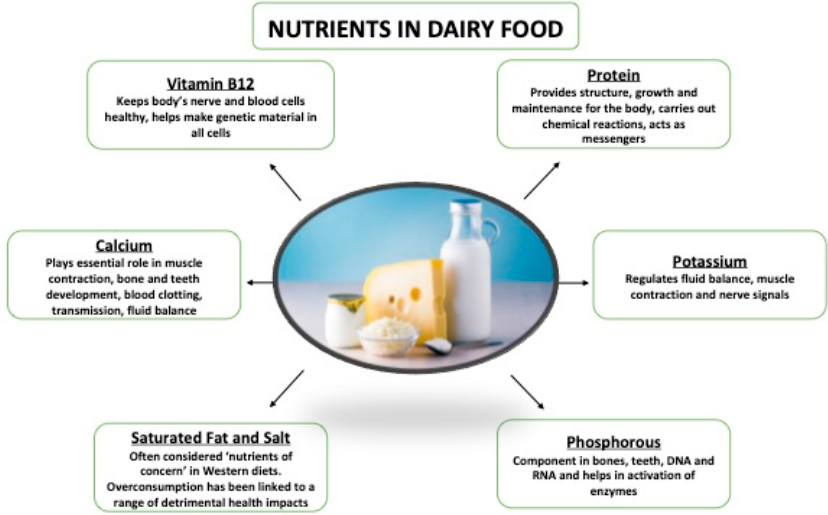
Figure 1. Nutrient content and associated health benefits of dairy consumption.